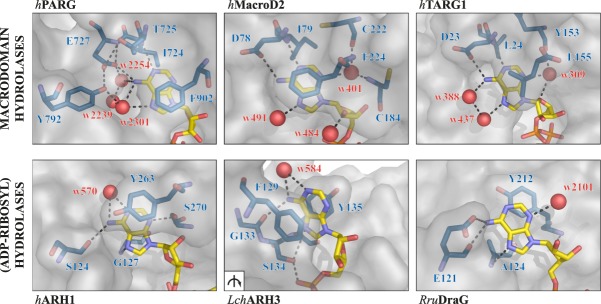
Comparison of adenine coordination across macrodomains and (ADP-ribosyl)hydrolases. Surface-liquorice representation of adenine coordination. The adenine base lies against the protein surface in most hydrolases with the exception of ARH3 in which it holds by π–π stacking perpendicular to the protein surface (view rotated [arrow] by ∼ 60° relative to the closeups). (Yellow) ADPr; (blue) coordinating residues; (red) waters; (dashed lines) selected polar contacts.